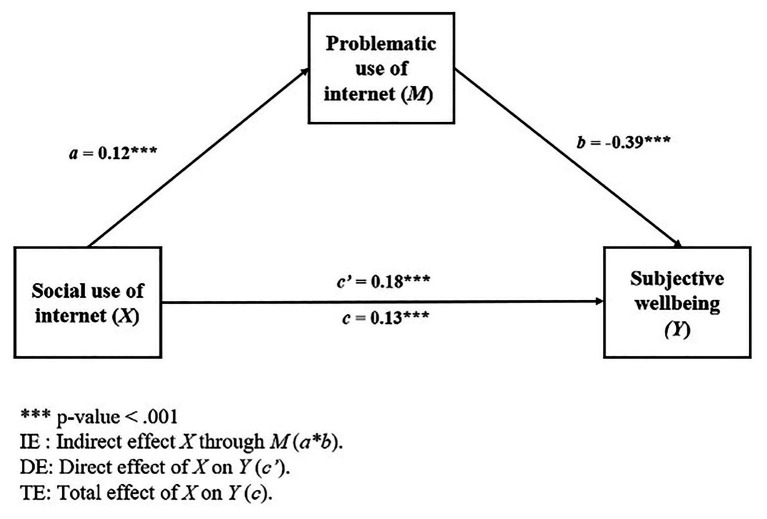
Mediational model 1.